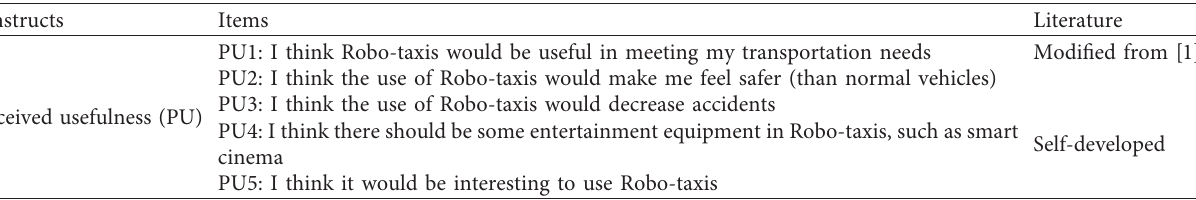
Table 2: Construct